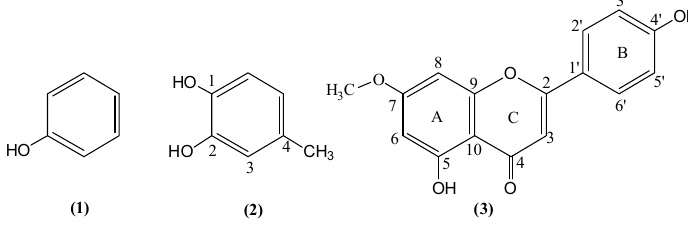
Figure 5. Chemical formulas of phenol ( 1 ), 4-methylcatechol ( 2 ), and genkwanin ( 3 ).